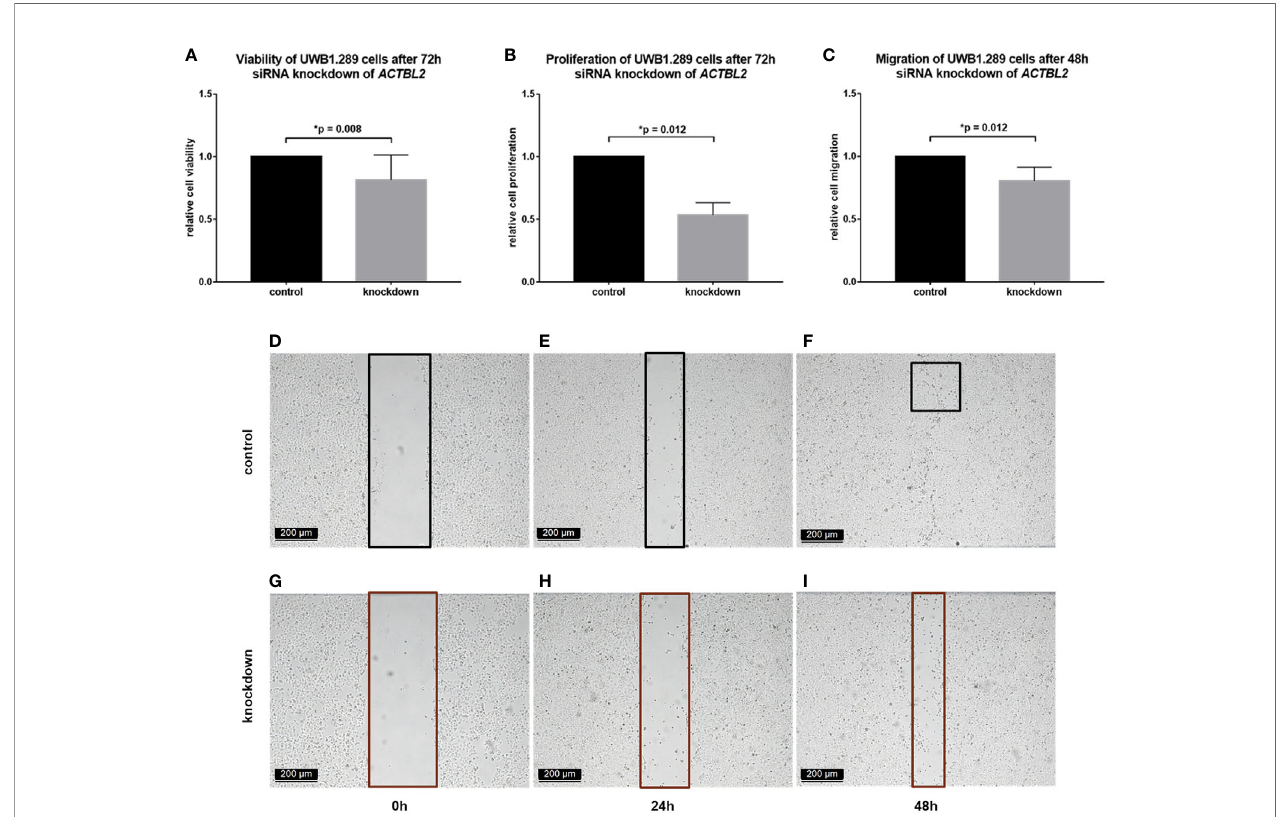
FIGURE 3 | Functional assays after ACTBL2 silencing in UWB1.289 cells. (A) MTT assay results after siRNA (sequence 3) knockdown of ACTBL2 , showing a signi fi cantly reduced cell viability (n=9, p =0.008). (B) BrdU assay results, displaying a signi fi cantly decreased cell proliferation after silencing of ACTBL2 (n=8, p =0.012) (C – I) Wound healing assay results (C) after siRNA knockdown of ACTBL2 , showing a signi fi cantly reduced migration of UWB1.289 cells after 48h (G – I) compared to the untreated control ( D – F ; n=8, p =0.012) (10x magni fi cation; scale